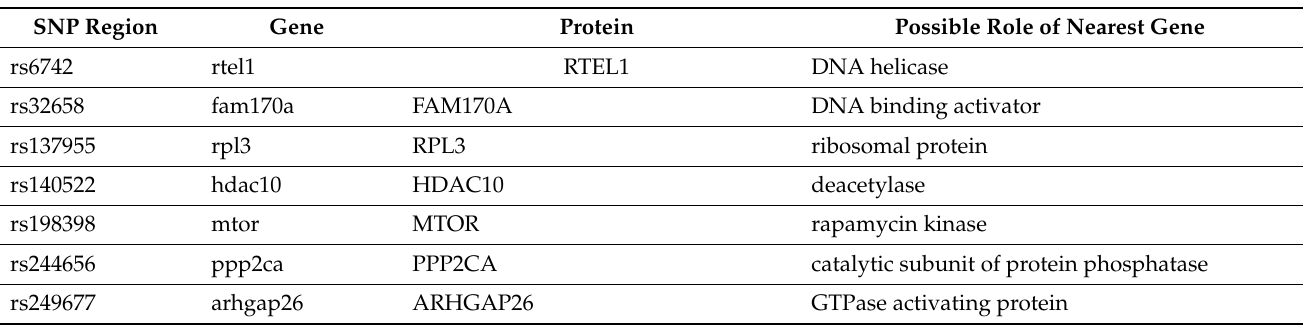
Table 1. The risk allele and its possible role for the 200 autosomal non-MHC genome-wide effects. This list shows the 200 SNP regions and the possible roles of probable genes associated with MS risks, as identified by SNP analyses